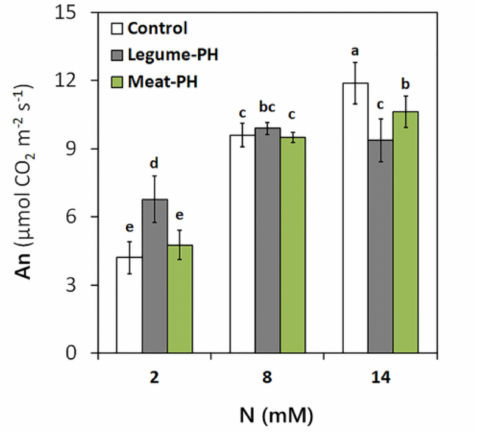
Figure 3. Effect of nitrogen doses and foliar application of biostimulants on the photosynthetic rate in spinach leaves. Vertical bars (standard error) ( n = 18) with different letters are significantly different according to the LSD test ( p =